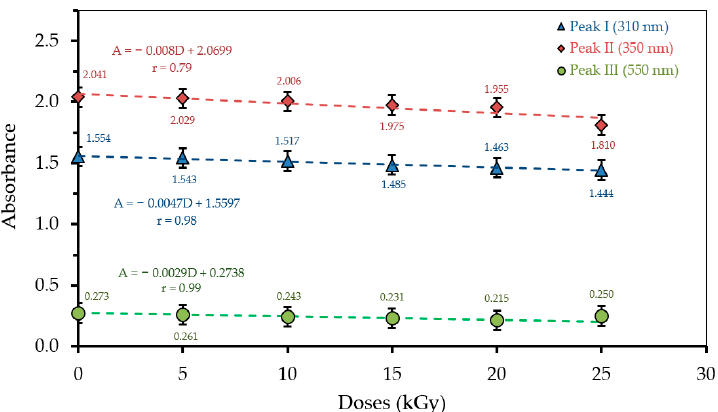
Figure 4. The relationship between radiation dose and absorbance of each λ (310, 350, and 550 nm) for H 3 PO 4 85 v% concentration. For peak III, the last absorbance datum was considered as outliers when plotting the trendline.